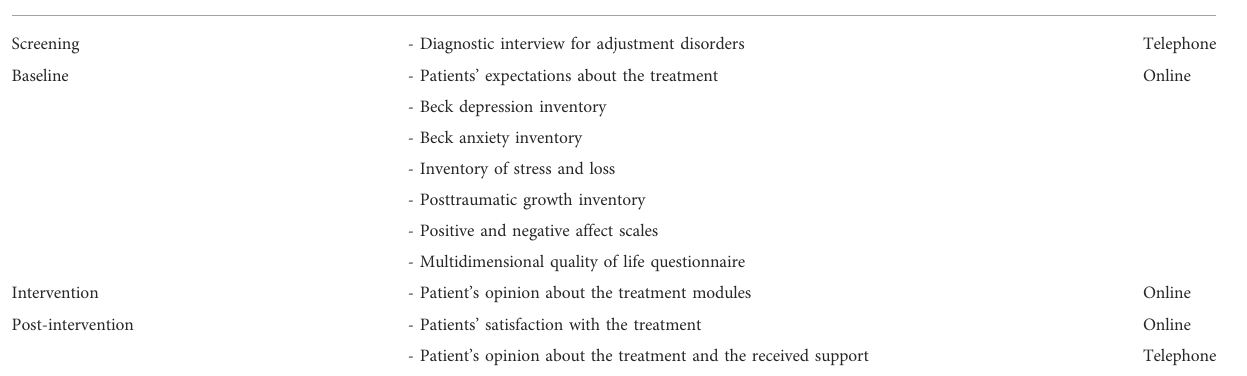
TABLE 2 Timing for each